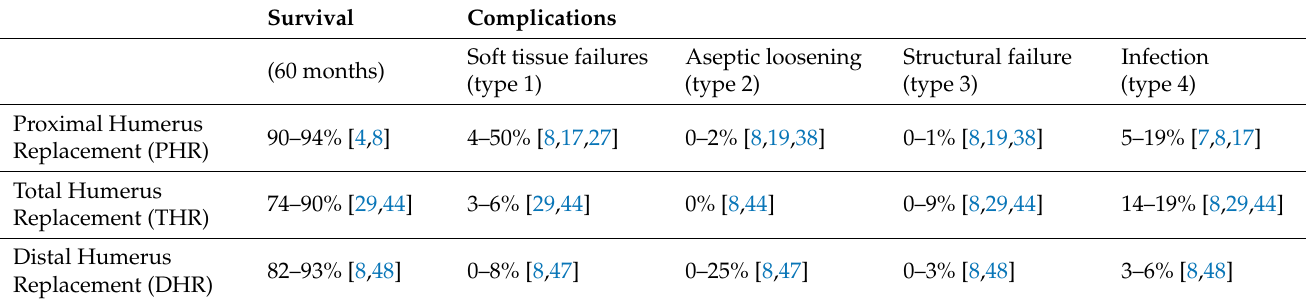
Table 1. Summary of survival and complications “Upper